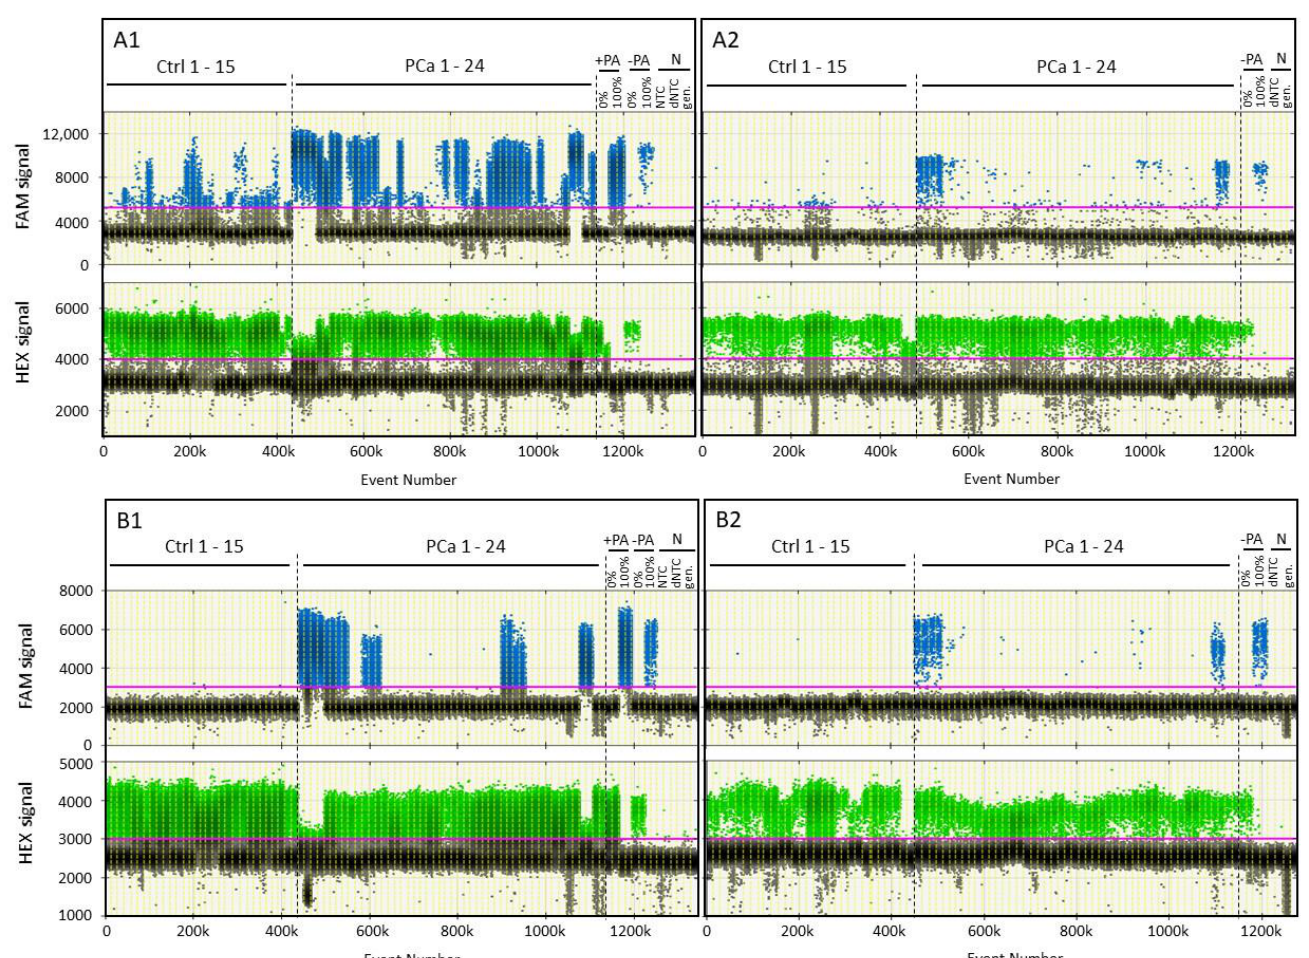
Figure 3. Diagnostic sensitivity of RASSF1A and GSTP1 DNA methylation analyses under optimised PCR conditions. DNA methylation analyses were performed for RASSF1A ( A ) and GSTP1 ( B ). Thresholds for FAM signals specific for methylated (blue, upper row) and HEX signals for unmethylated (green, lower row) DNA sequences were 5200/3000 RFU for RASSF1A and 3000/3000 RFU for GSTP1 . Serum pools of healthy individuals (Ctrl) and prostate carcinoma (PCa) patients were analysed by OBBPA-ddPCR ( A1 , B1 ) and ddPCR alone ( A2 , B2 ). As control measurements, unmethylated (0%) and methylated (100%) DNA standards as well as no-template controls (dNTC without and NTC with pre-amplification) were analysed before (−PA) and after (+PA) pre-amplification. Genomic DNA standards without prior bisulfite treatment (gen.) were tested by ddPCR to ensure specific detection of bisulfite treated DNA.